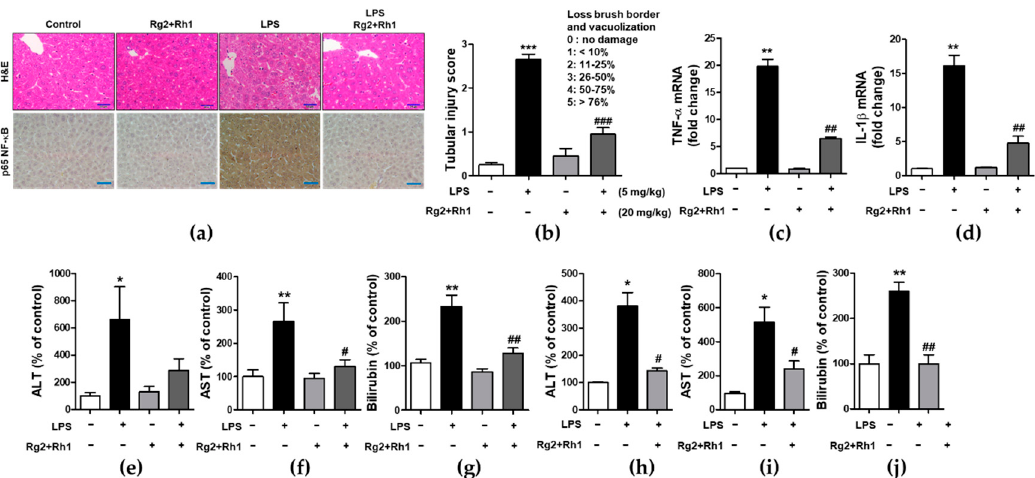
Figure 5. Effect of ginsenosides Rg2 and Rh1 on pathological changes and liver function in LPS-challenged mice. ( a – g ) Mice were i.p. injected with ginsenosides Rg2 and Rh1 combination (1:1 ratio, 20 mg / kg) for 2 h followed by treatment with LPS (5 mg / kg) for 6 h. ( a ) Pathological changes of acute liver injury with hematoxylin and eosin (H&E) staining with scale bar 50 µ m and immunohistochemical detection of NF- κ B p65 expression in mouse liver sections with scale bar 100 µ m. ( b ) Bar graph represents histological score for liver sections ( n = 8). ( c , d ) The liver lysates were subjected to qRT-PCR to examine the levels of pro-inflammatory cytokines. ( e – g ) The level of serum alanine transaminase (ALT), aspartate transaminase (AST), and bilirubin were detected from mouse serum. ( h – j ) Mice were i.p. injected with Rg2 and Rh1 combination (1:1 ratio, 20 mg / kg) for 24 h followed by treatment with LPS (10 mg / kg) for 24 h. The level of serum ALT, AST, and bilirubin were detected from mouse serum. Data are represented as mean ± SEM ( n = 6). * p < 0.05, ** p < 0.01, and *** p < 0.001 compared with control sample, # p < 0.05, ## p < 0.01, and ### p < 0.001 compared with LPS-treated